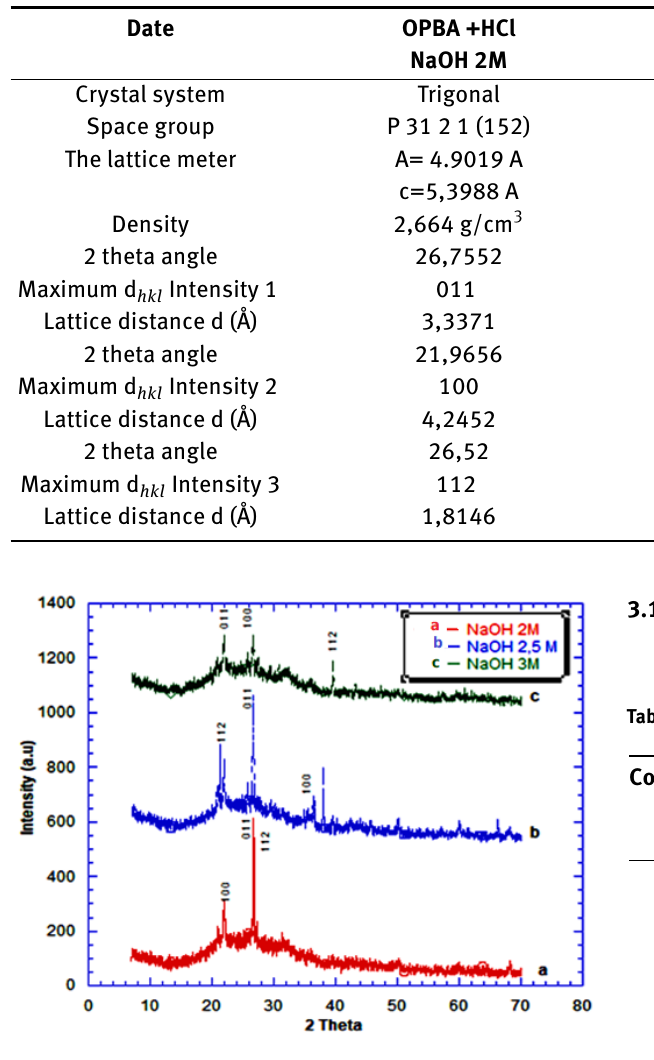
Figure 1: OPBA diffraction pattern with variation of NaOH solution